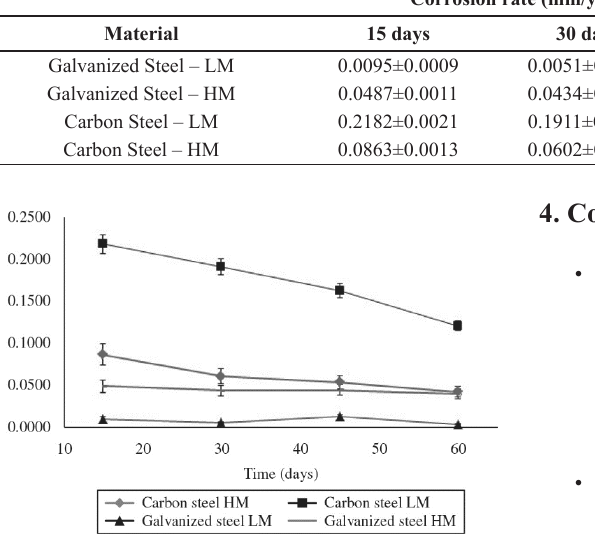
Figure 6. Corrosion rates obtained by the gravimetric method (HM: High moisture e LM: Low